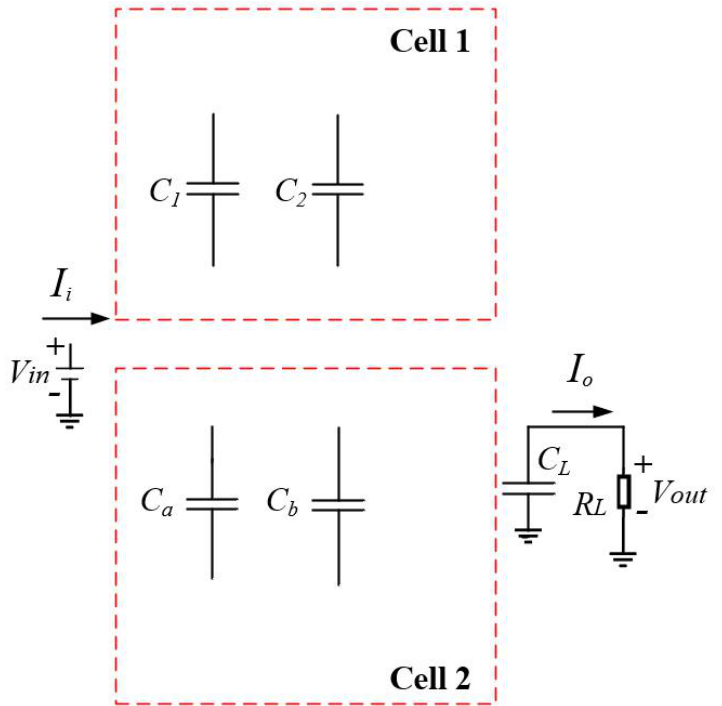
Figure 6. Instantaneous equivalent circuit during dead-time.